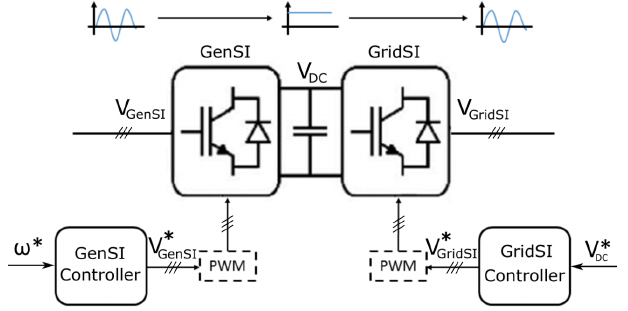
Figure 4. Diagram of a back-to-back power converter with controllers and pulse width modulators. GenSI, generator-side